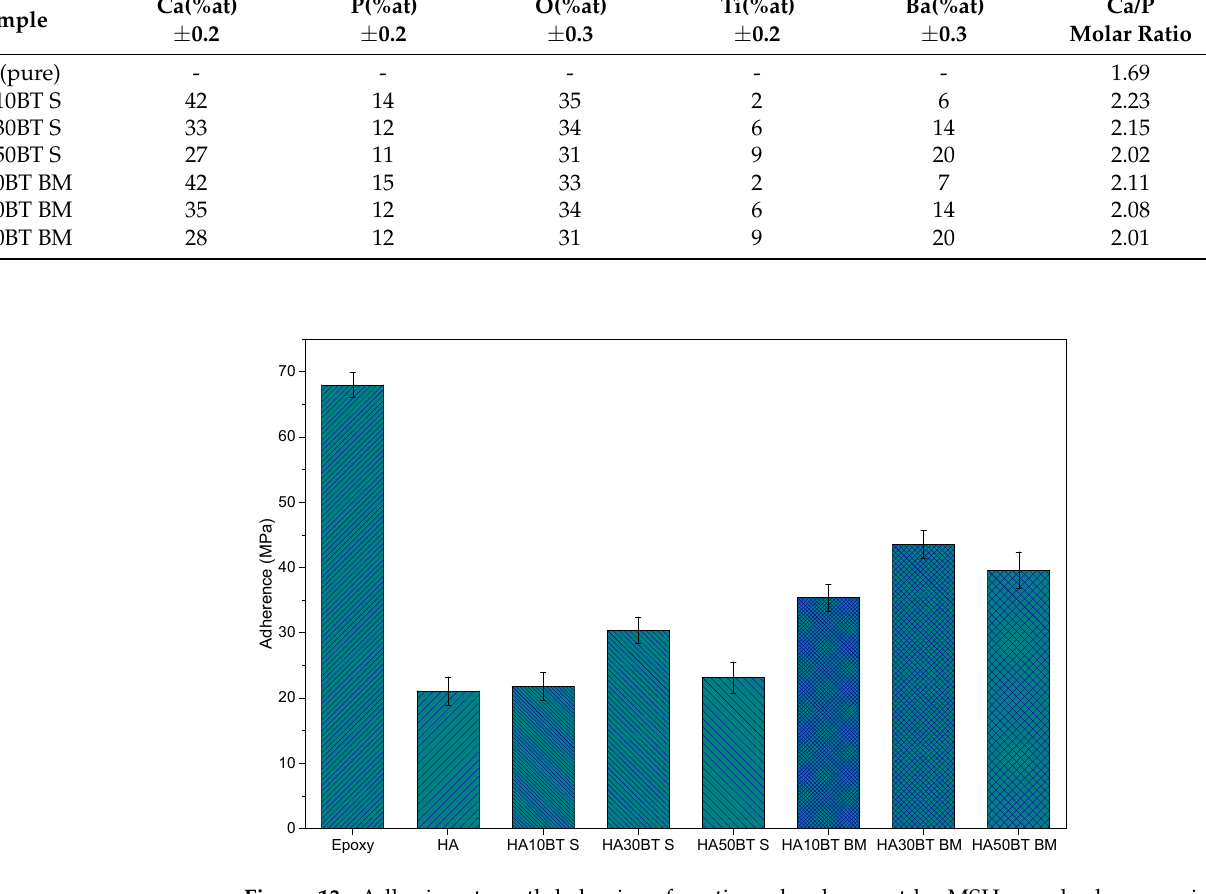
Figure 13. Adhesive strength behavior of coatings development by MSH powder homogenization process and high energy ball milling powder homogenization process. Epoxy and HA as a comparative control. Table 4. Adhesives strength values and standard deviation of samples.